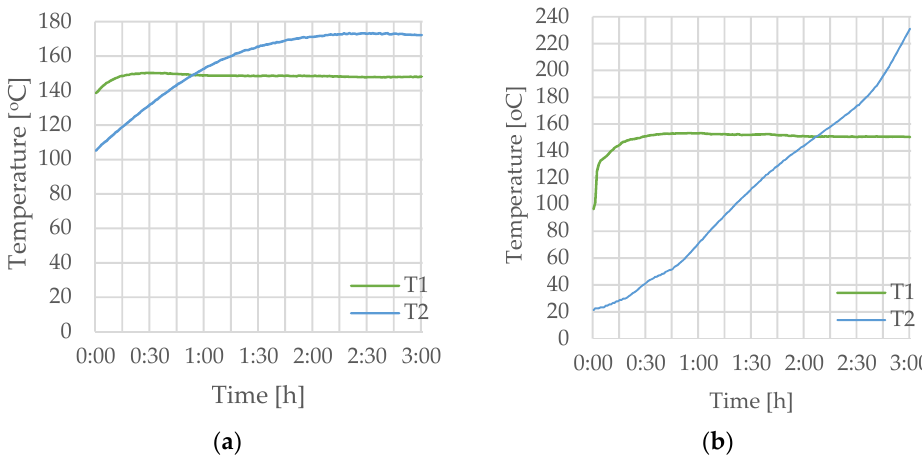
Figure 5. The temperature of sludge dust in a 50.27 cm 3 basket: ( a ) at a furnace temperature of 148 °C with no evidence of dust ignition, ( b ) at a furnace temperature of 150 °C with a dust ignition.